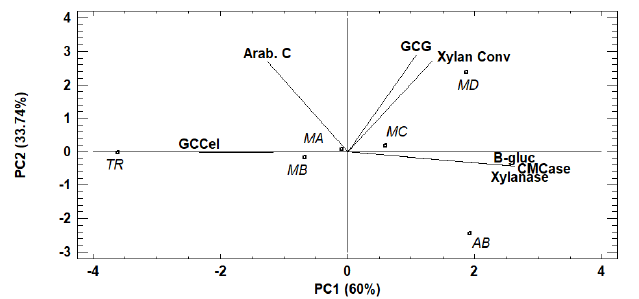
Figure 2. Principal components analysis biplot of effect of enzymatic mixtures on